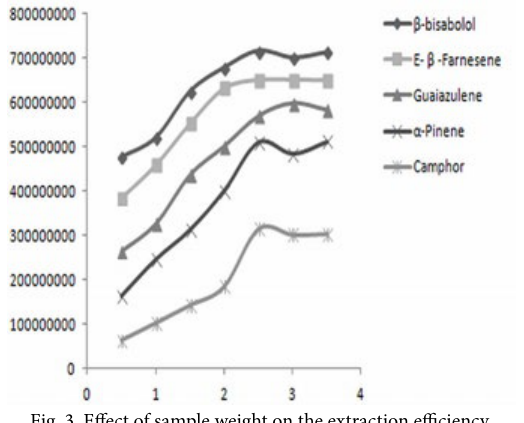
Fig. 3. Effect of sample weight on the extraction efficiency. (X=gr, Y=area peak)